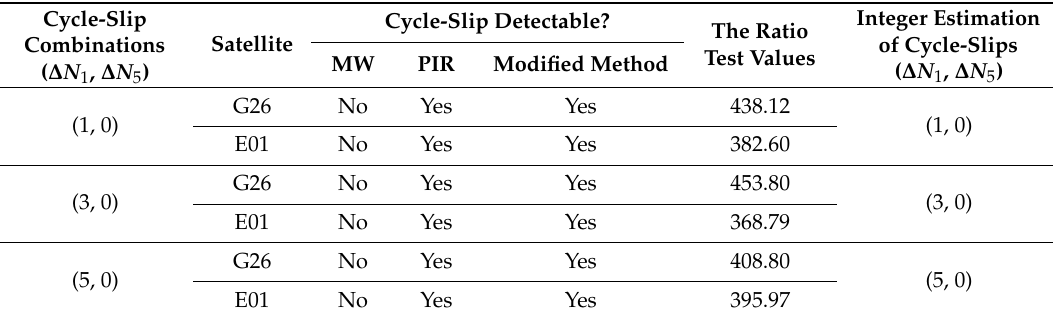
Table 1. Summary of the small cycle-slips detection and correction results.